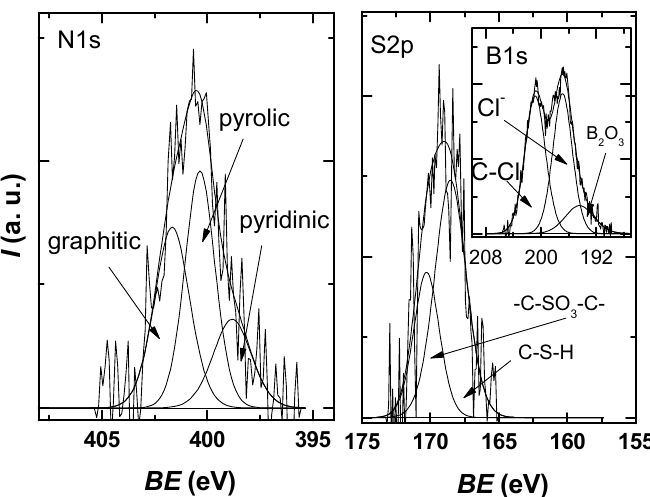
Figure 6. N1s and S2p XPS high-resolution spectra for the investigated sample, each with the de ‐ convolution into characteristic components.